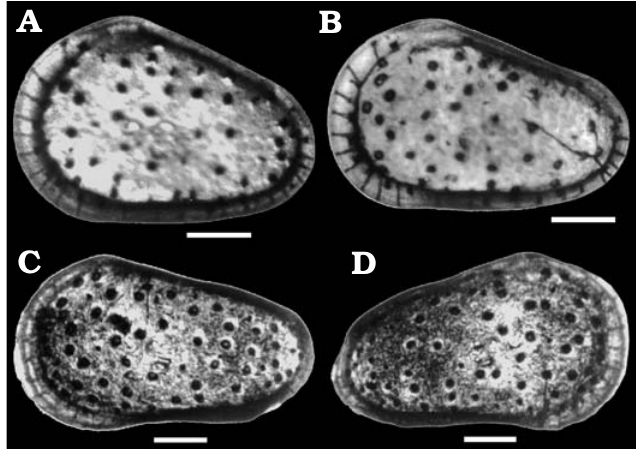
Fig. 9. Marginal pore canals of cytherid ostracods Minyocythere macro- porosa sp. nov. and Minyocythere angulata sp. nov. A , B . Minyocythere angulata sp. nov. from Borehole Hambühren WA2, 203 m, NW Germany, Upper Aalenian (Braun Jura β ). A . SMF Xe 23742 (specimen broken), female right valve in internal view. B . Unnumbered (specimen missing), male right valve in internal view. C , D . Minyocythere macroporosa sp. nov. from Hambühren WA2, 166 m, NW Germany, Upper Aalenian (Braun Jura β ). C . Holotype, SMF Xe 23721, male left valve in external view. D . Paratype, SMF Xe 23722, female right valve in external view. Light micrographs by Erich Triebel. Scale bars 100 μ